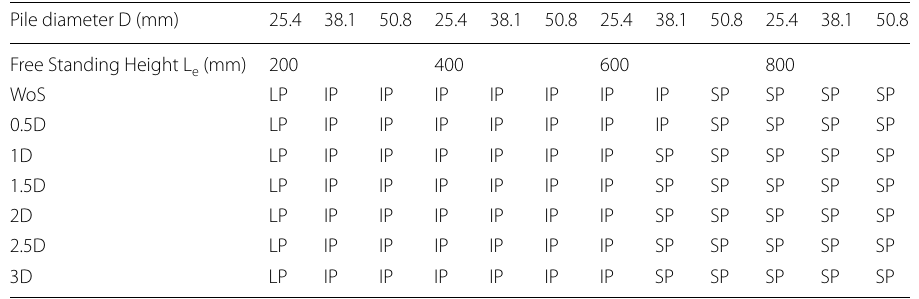
LP Long flexible pile, IP intermediate pile, SP short rigid pile, D diameter of pile, WoS without Socketing